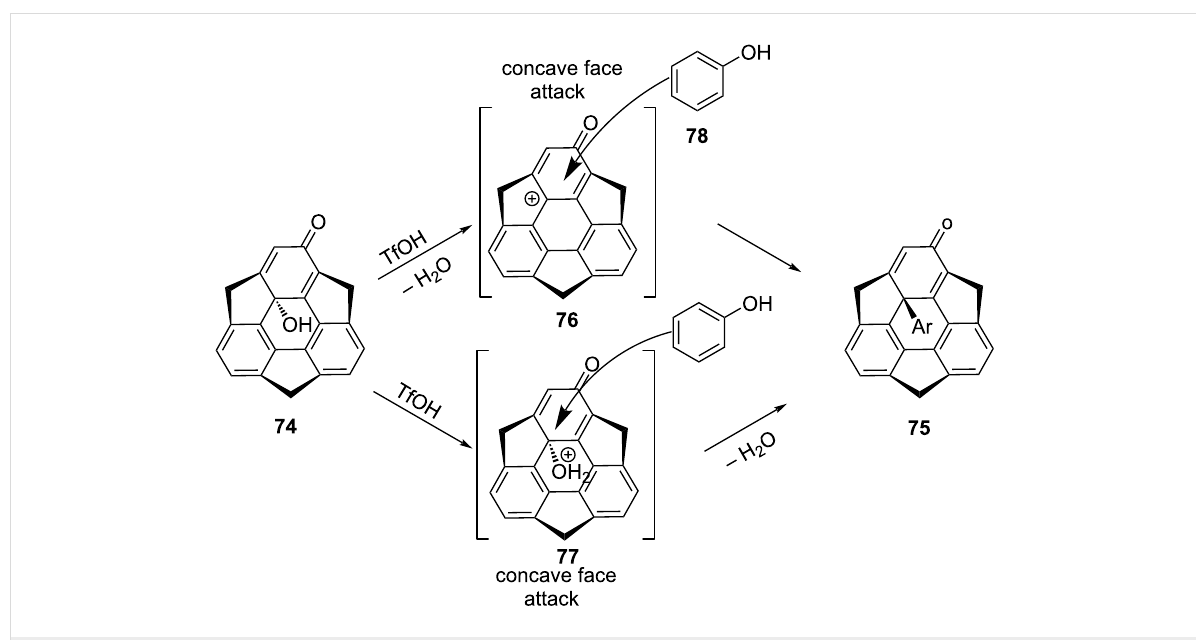
Scheme 17: Mechanism for nucleophilic substitution reaction at the internal